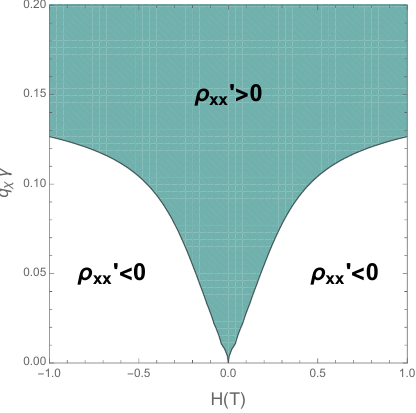
Figure 5 . (a) Metalicity, the sign of @(cid:26) xx =@T , as a function of Magnetic doping and magnetic (cid:12)eld. Negative (white) regions indicate the